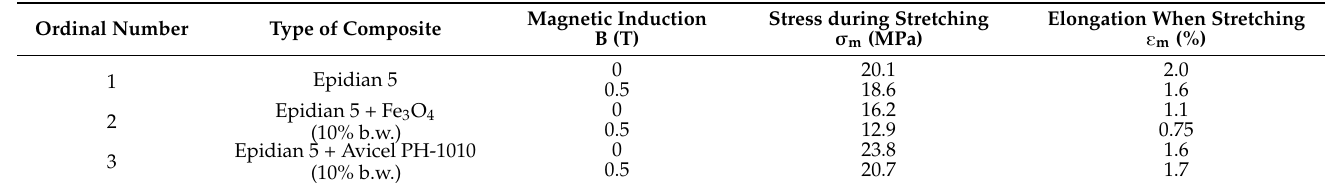
Table 8. Comparison of the mechanical tensile strength of composites.